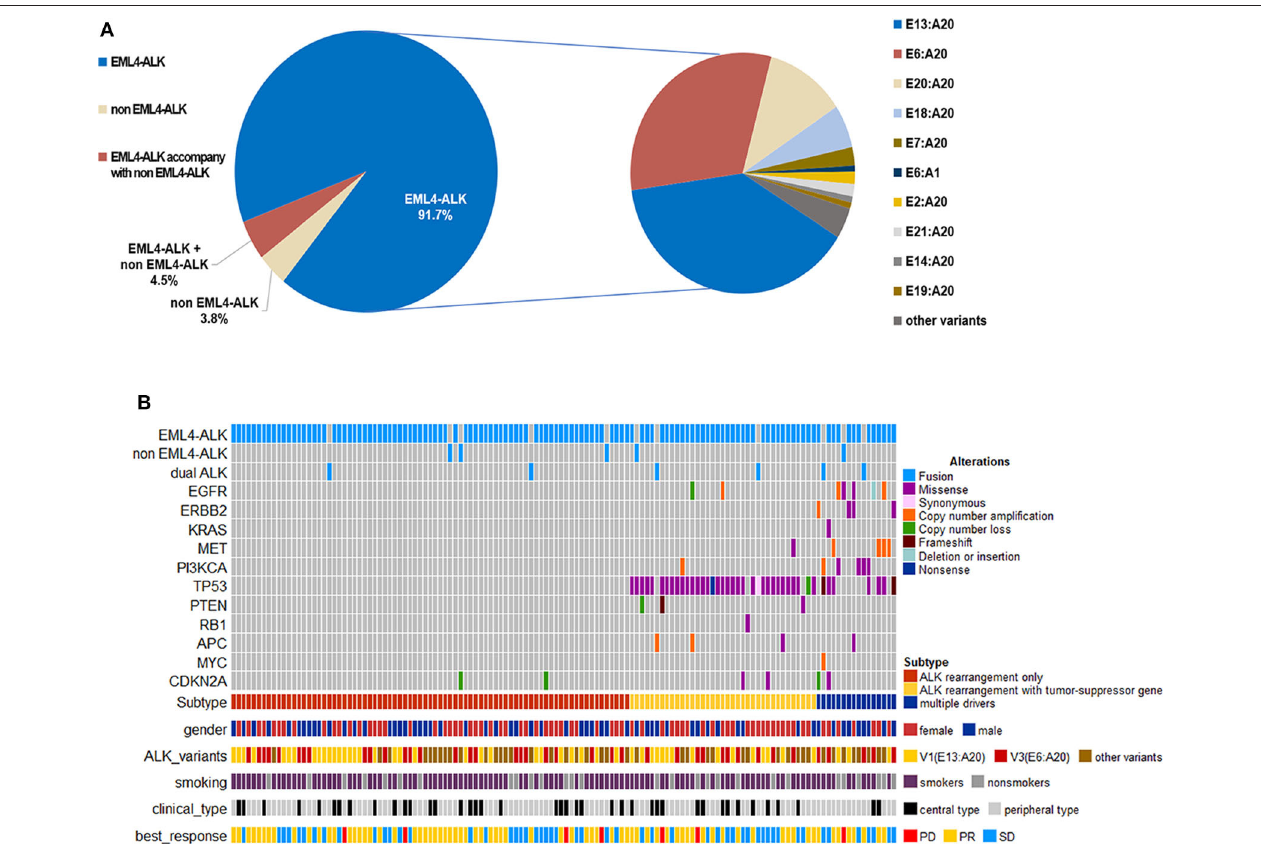
FIGURE 1 | (A) Frequency of ALK variants in the study cohort ( n = 132). (B) Distribution of concomitant mutations stratified by subgroups according to baseline NGS sequencing and their clinical